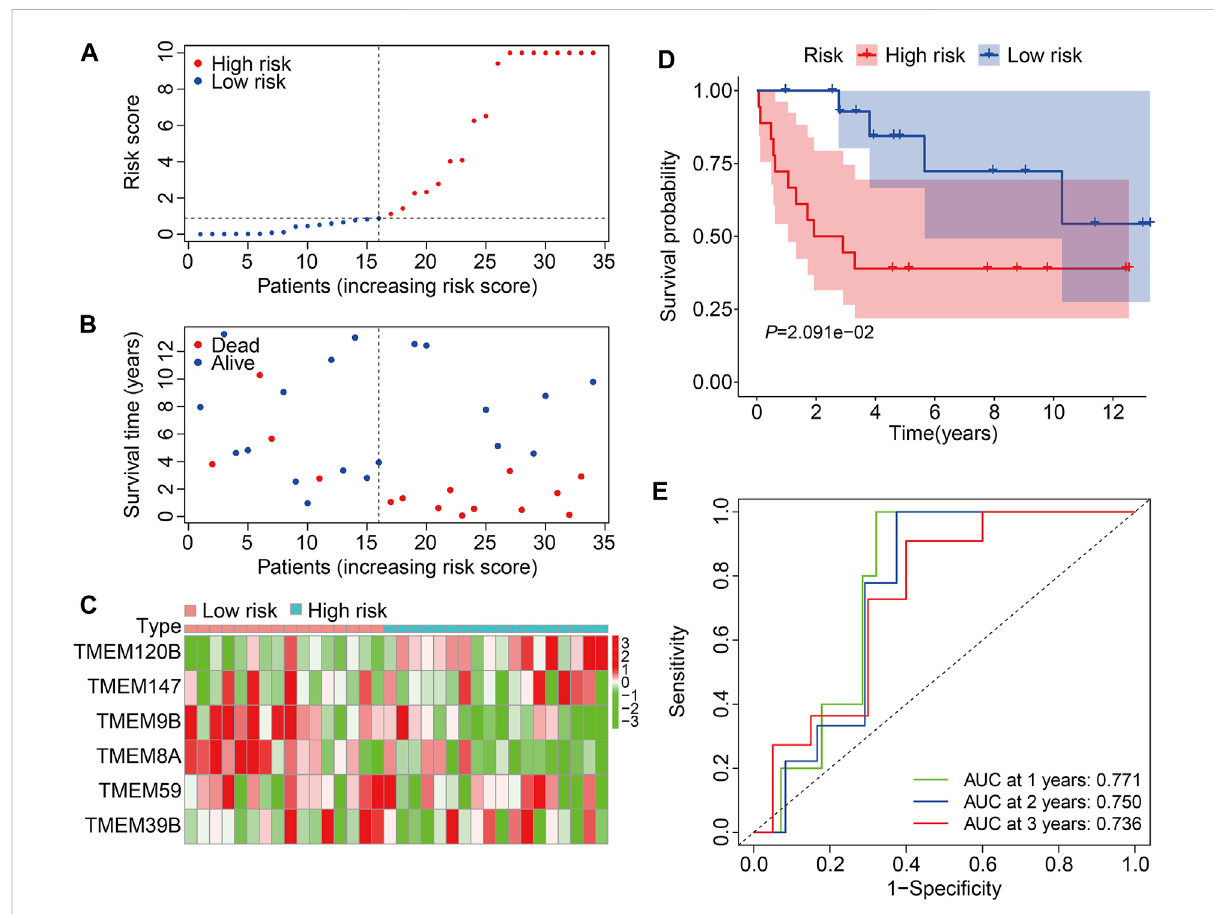
FIGURE 5 Validation of the TMEM protein family gene-based signature in external cohorts. (A) Dot plots exhibit risk score distribution in the GSE16091 cohort. (B) Dot plots show the comparison of the survival time and survival status of osteosarcoma patients in the GSE16091 cohort. (C) Heatmapforcomparisonofthegeneexpressionlevelsinthehigh-andlow-riskgroups. (D) Kaplan – Meiersurvivalanalysisforthecomparisonofthe overall survival between the high- and low-risk group. (E) Time-dependent ROC curve for 1-, 2-, and 3-year overall survival in the GSE16091 cohort.